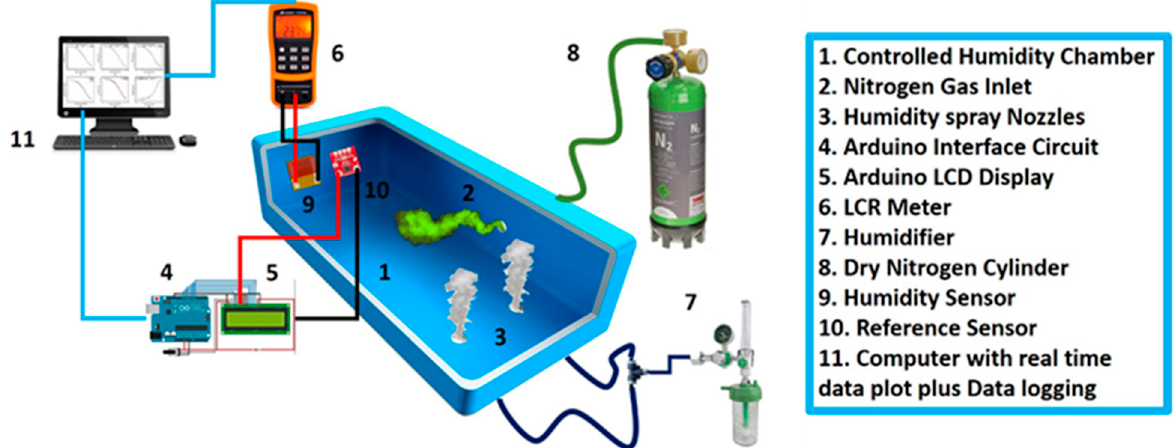
Figure 3. Schematic diagram of highly controllable measurement setup for obtaining the impedance data of the developed humidity sensor with thorough labeling of each part.